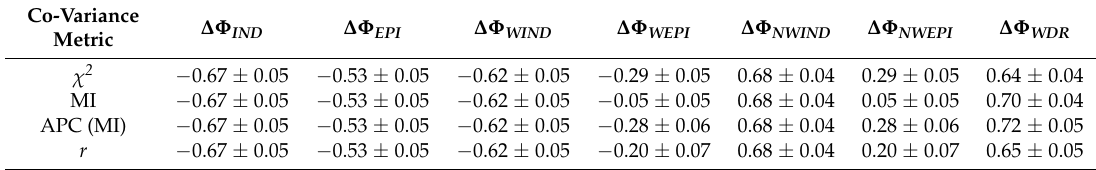
* Models independent of co-variance metrics have constant results and included here for comparison.